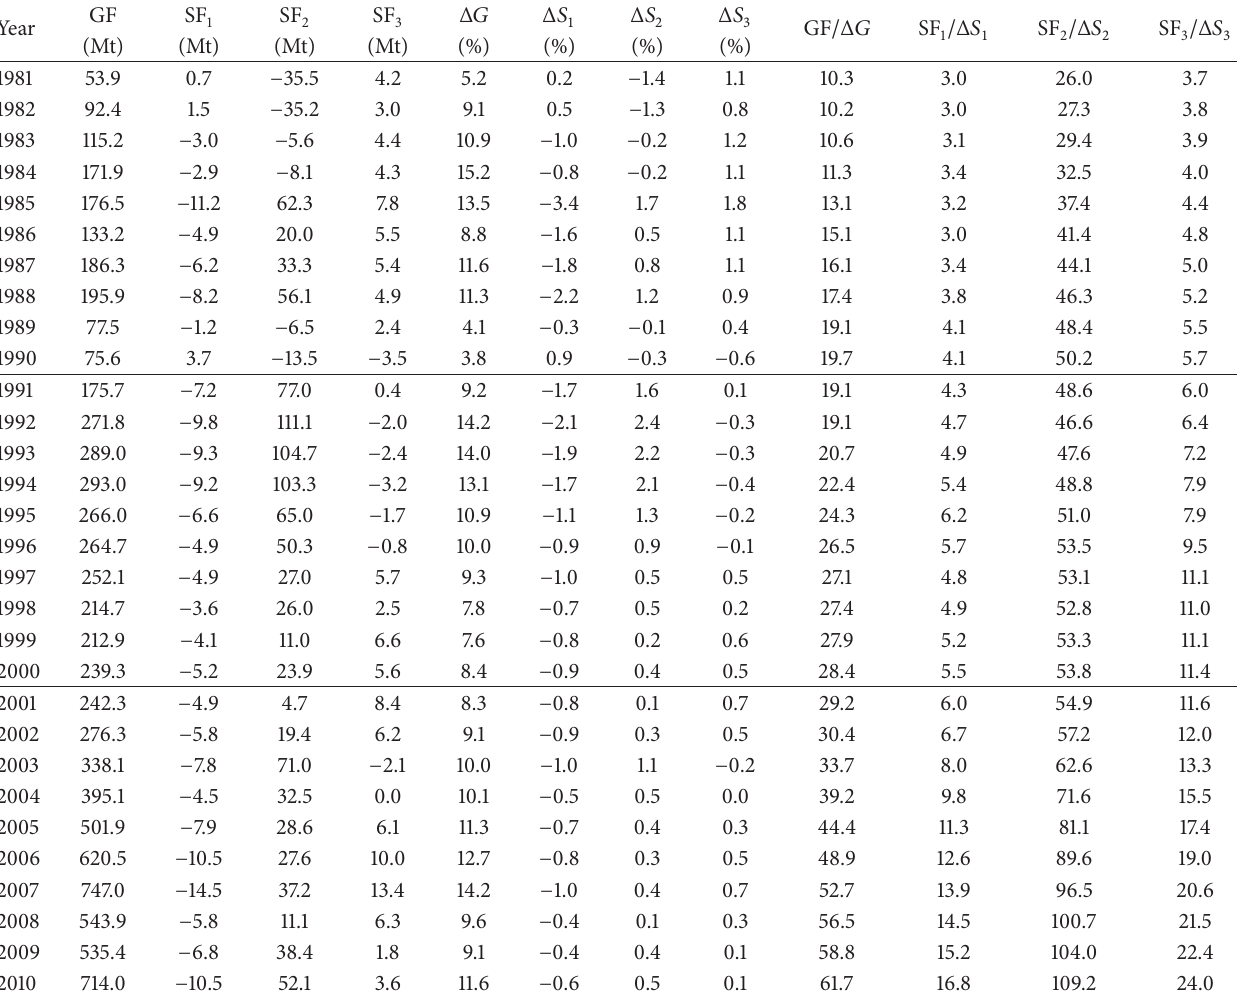
Table 6: Decomposition results of economy and structure factor